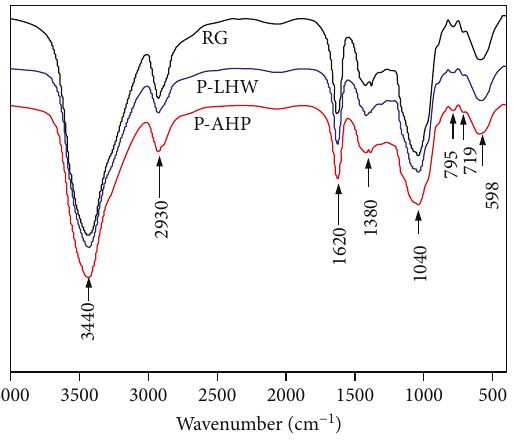
Figure 3: FTIR spectra of the polysaccharide fractions.